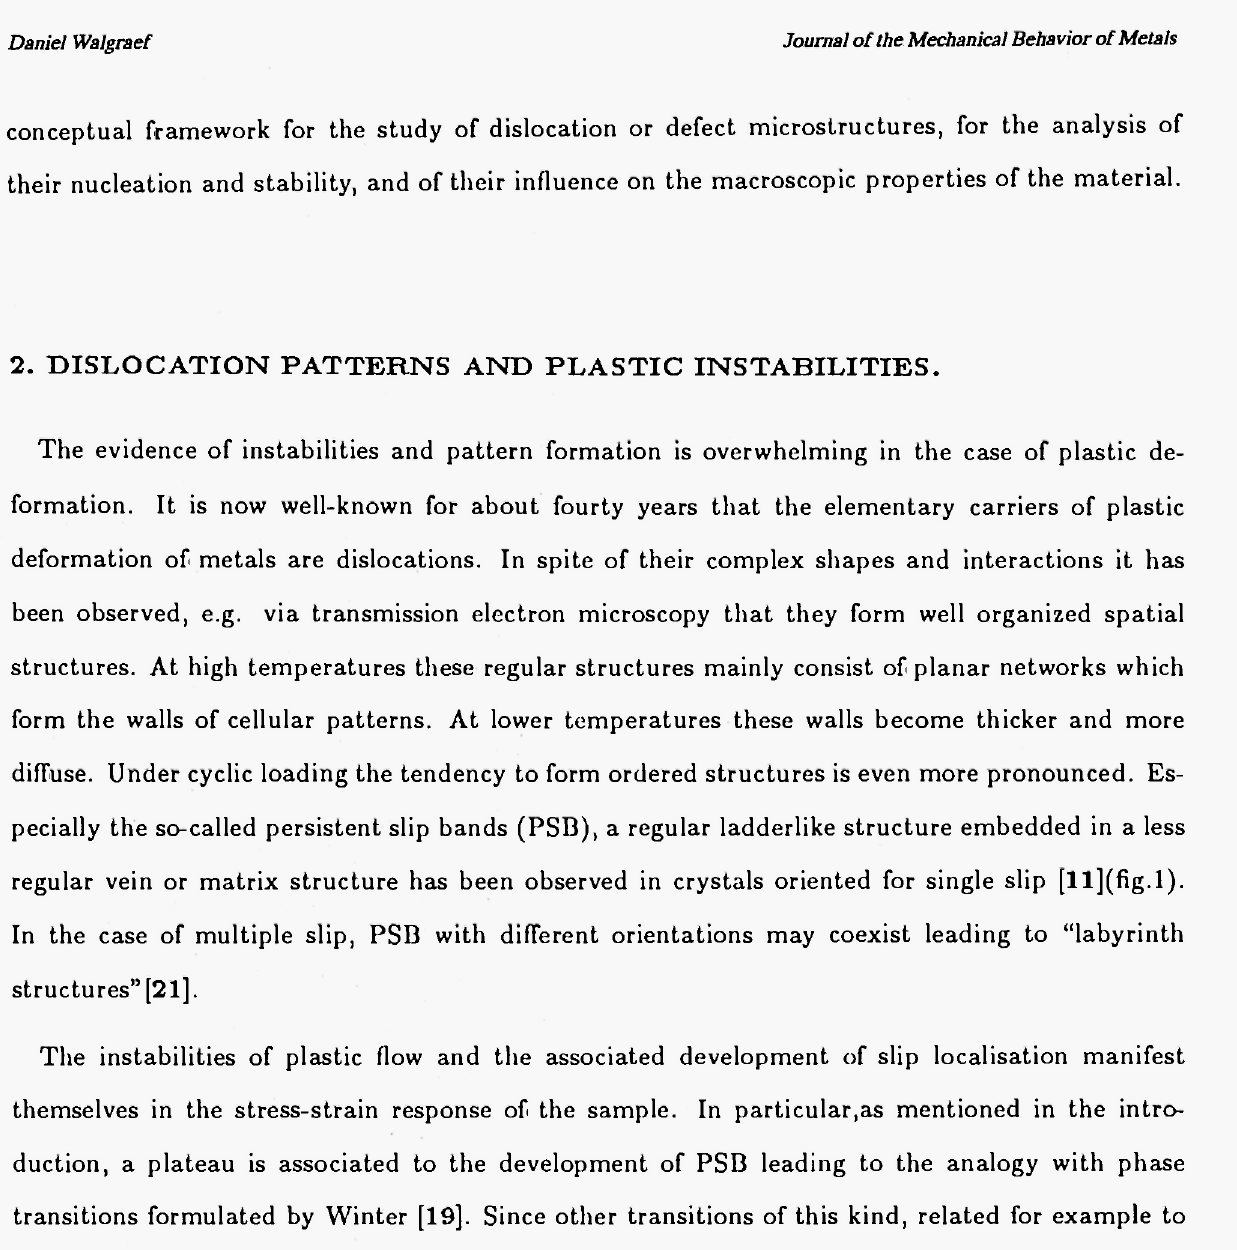
conceptual framework for the study of dislocation or defect microstructures, for the analysis of their nucleation and stability, and of their influence on the macroscopic properties of the